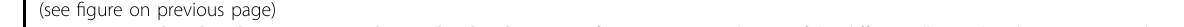
(e.g., Cebpb for c13, Ezh2 for c14, and Irf7 for c10), which might represent key regulators for maintenance of the speci fi c cellular states.